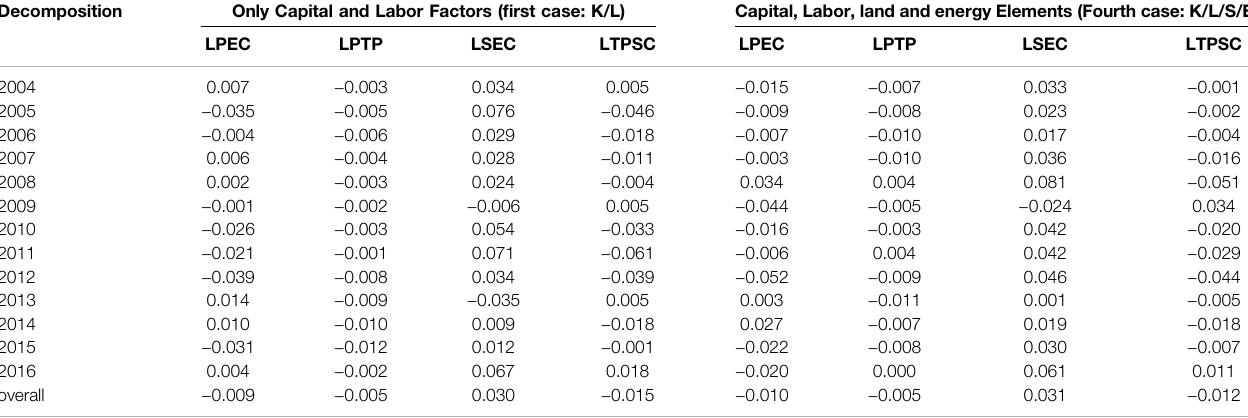
TABLE 3 | Decomposition of GTFP growth. Decomposition Only Capital and Labor Factors ( fi rst case: K/L)